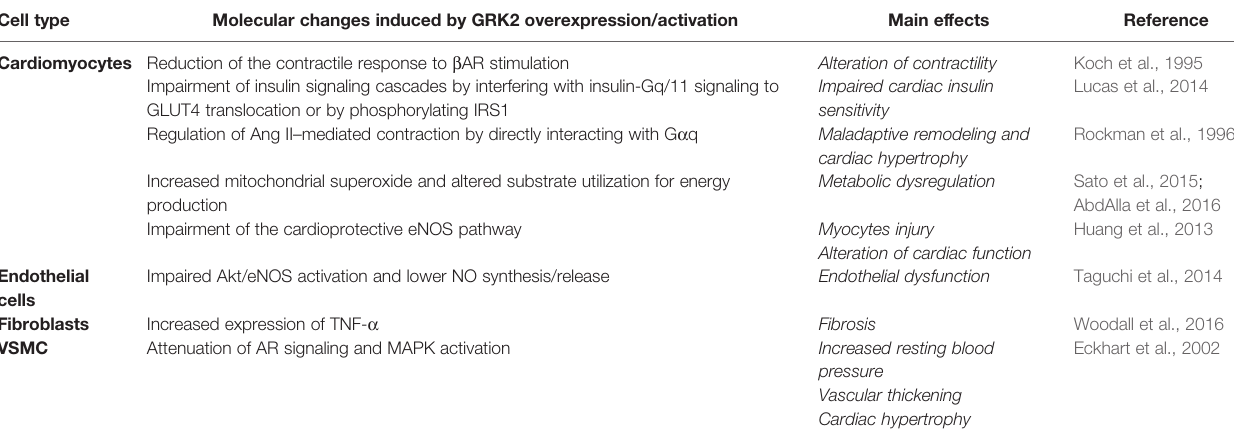
TABLE 4 | Molecular changes and main effects associated to GRK2 overexpression in different cell types associated to cardiovascular disease. Cell